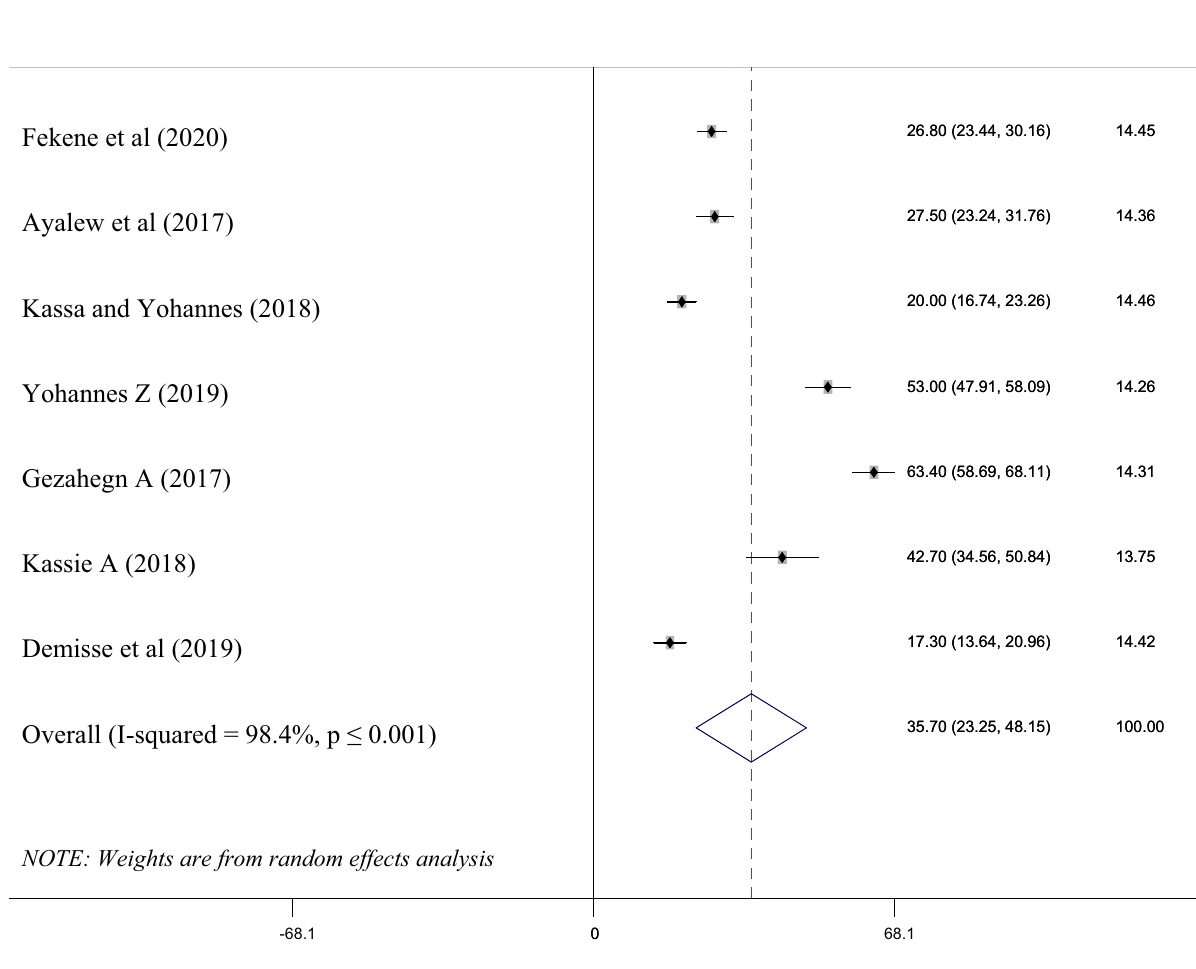
Figure 2. Shows the pooled estimated knowledgeable women about preconception care in